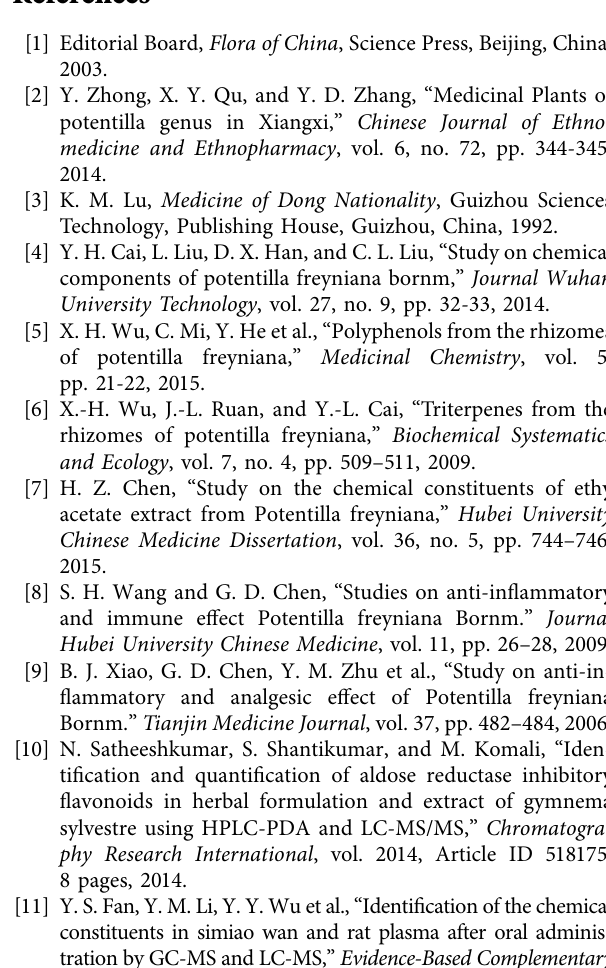
Figure S1: compounds-target genes. Figure S2: PPI network. Table S1: compounds-target genes. Table S2: GO analysis. Table S3: KEGG pathway . ( Supplementary Materials )